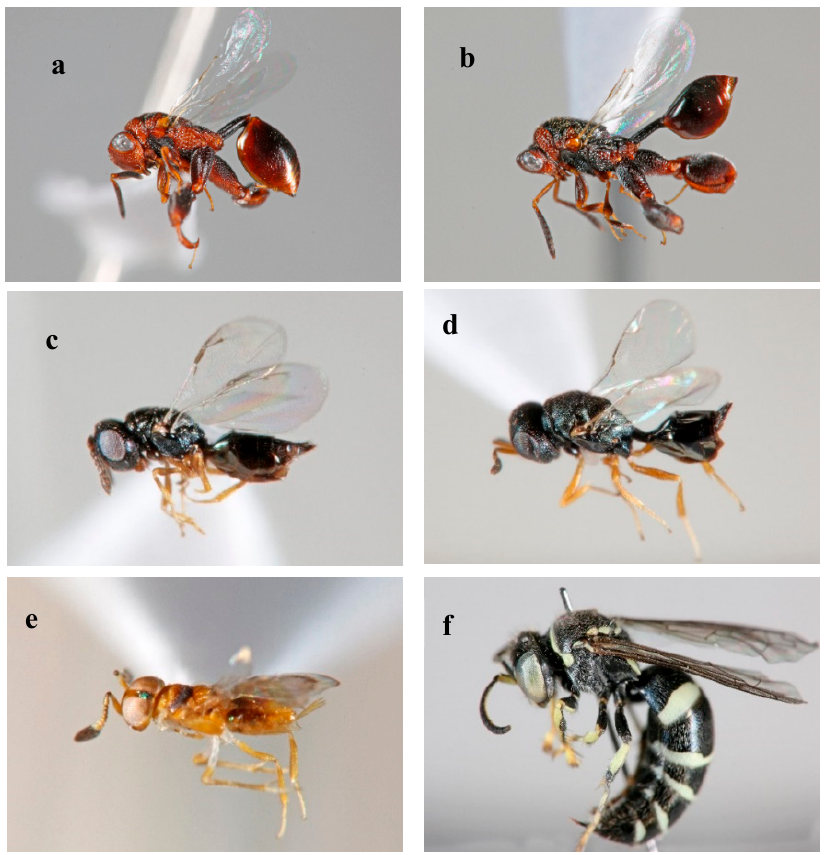
Figure 4. Parasitoids reared from avocado fruits ( a , b ) Epitranus sp. nov.; ( c ) Toxeumorpha nigricola ; ( d ) Pachycrepoideus vindemmiae ; ( e ) Cheiloneurus sp ; and ( f ) Bembecinus sp.